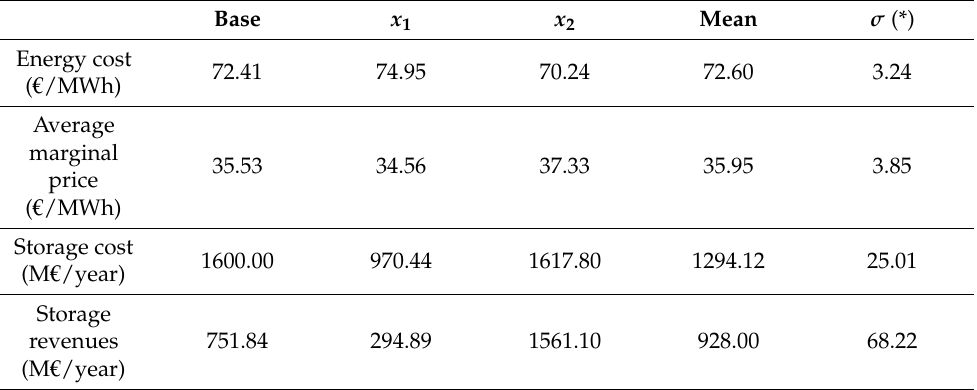
Table 6. Cost of energy and storage.